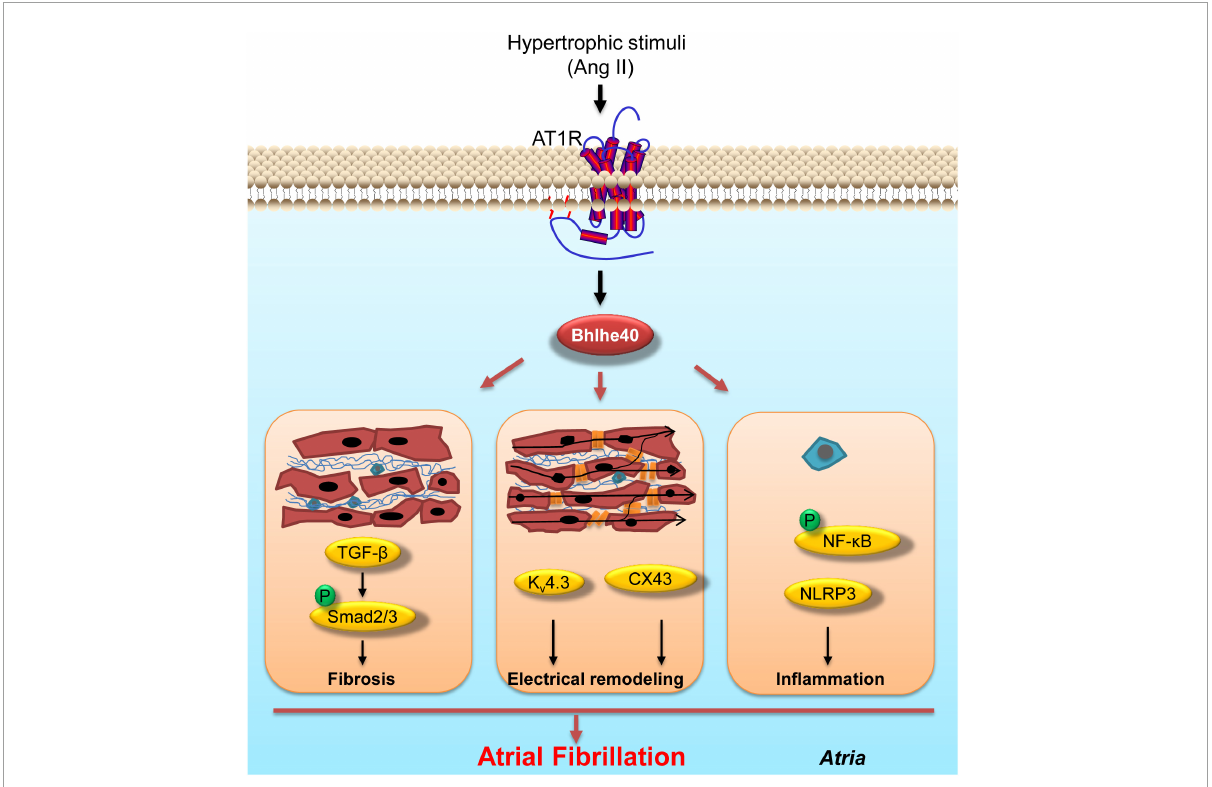
FIGURE7 Working model of the effect of knockdown of Bhlhe40 on Ang II-induced AF. Cardiac-specific knockdown of Bhlhe40 suppresses Ang II-induced atrial inflammation, atrial fibrosis, electrical remodeling, and signaling pathways (NF- κ B, NLRP3/IL-1 β , TGF- β /Smad2, Kv4.3, and CX43) in